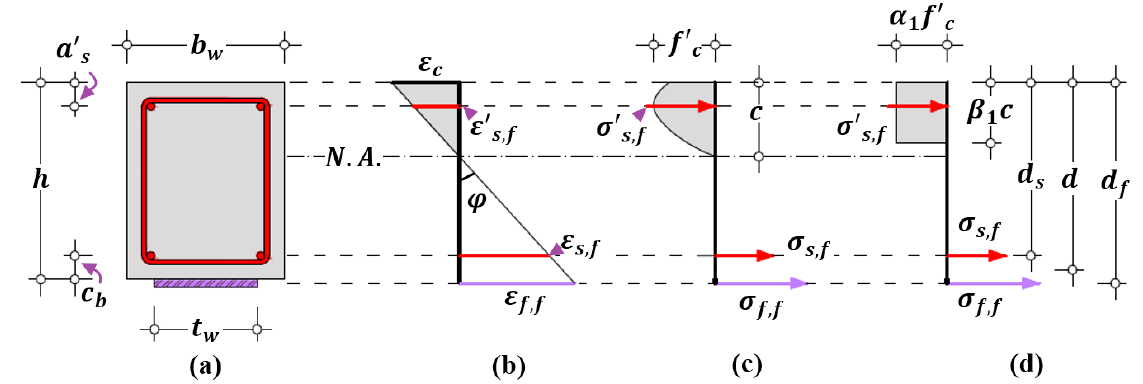
Figure 18. Geometries of beam section and profiles of strain and stress under flexural action: ( a ) beam cross-section; ( b ) strain distribution; ( c ) stress distribution; and ( d ) simplified stress distribution. (Note: N.A.= neutral axis).